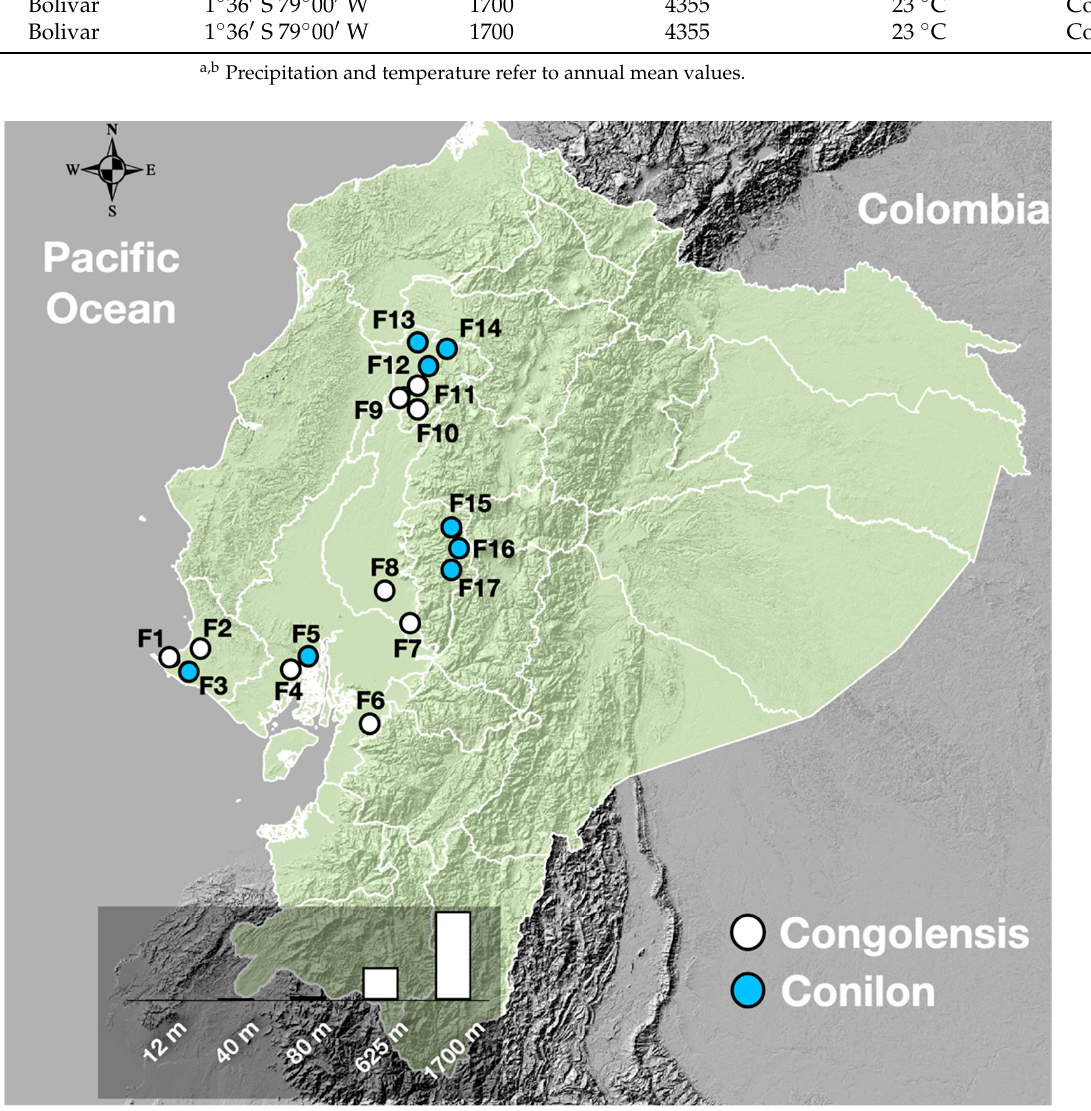
Figure 1. Sampling points in Ecuador.